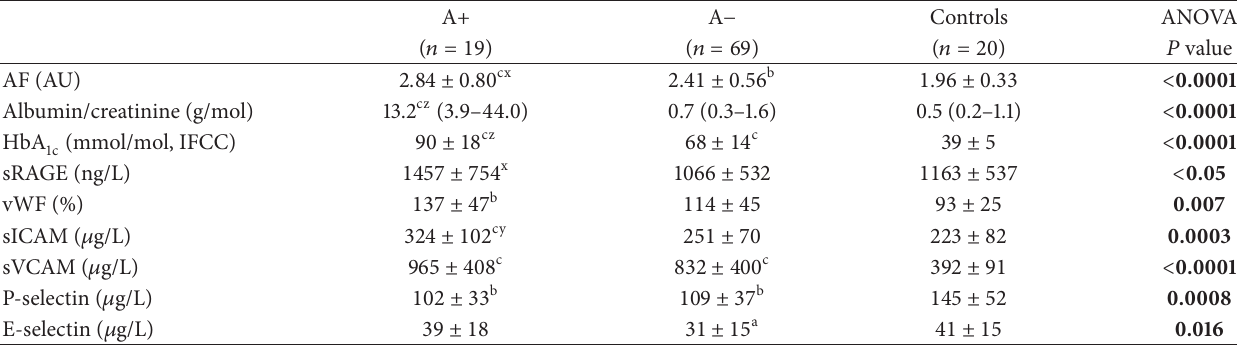
Table 3: Skin autofluorescence and novel biochemical parameters in subgroups without (A − ) and with (A+) (micro)albuminuria according to ACR.